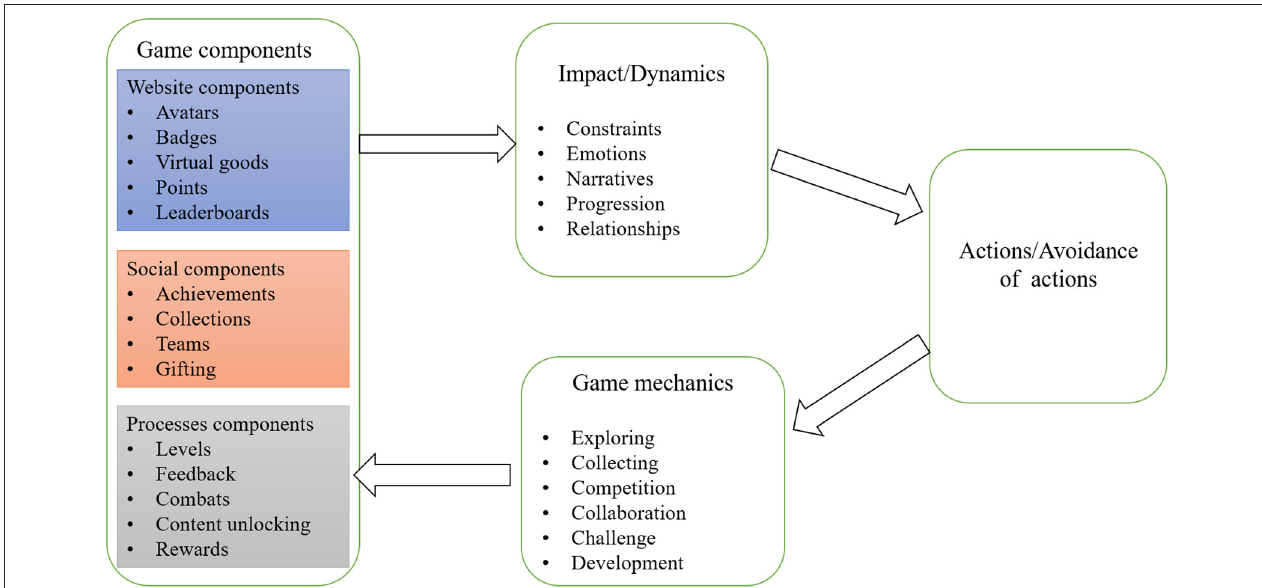
FIGURE 2 | A conceptual model of the impact of gamification on consumer behavior.